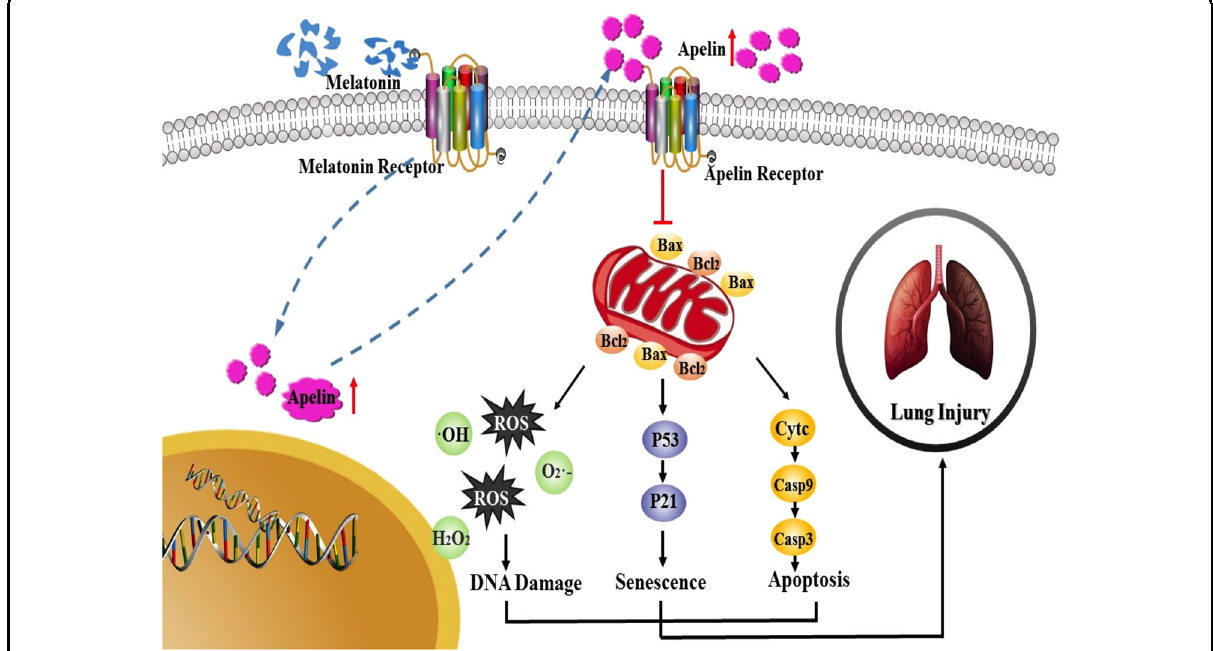
Fig. 7 Schematic model describing the protective effect of melatonin on the restoration of mitochondrial homeostasis and function in AECIIs. Injury of AECIIs led to mitochondrial dysfunction, ROS release, and decreased ATP content. Melatonin supplementation modi fi ed injury through an epithelial protective effect via apelin 13 and its receptors, which resulted in the restoration of normal mitochondrial function and, eventually, rescued from mitochondria-regulated apoptosis and